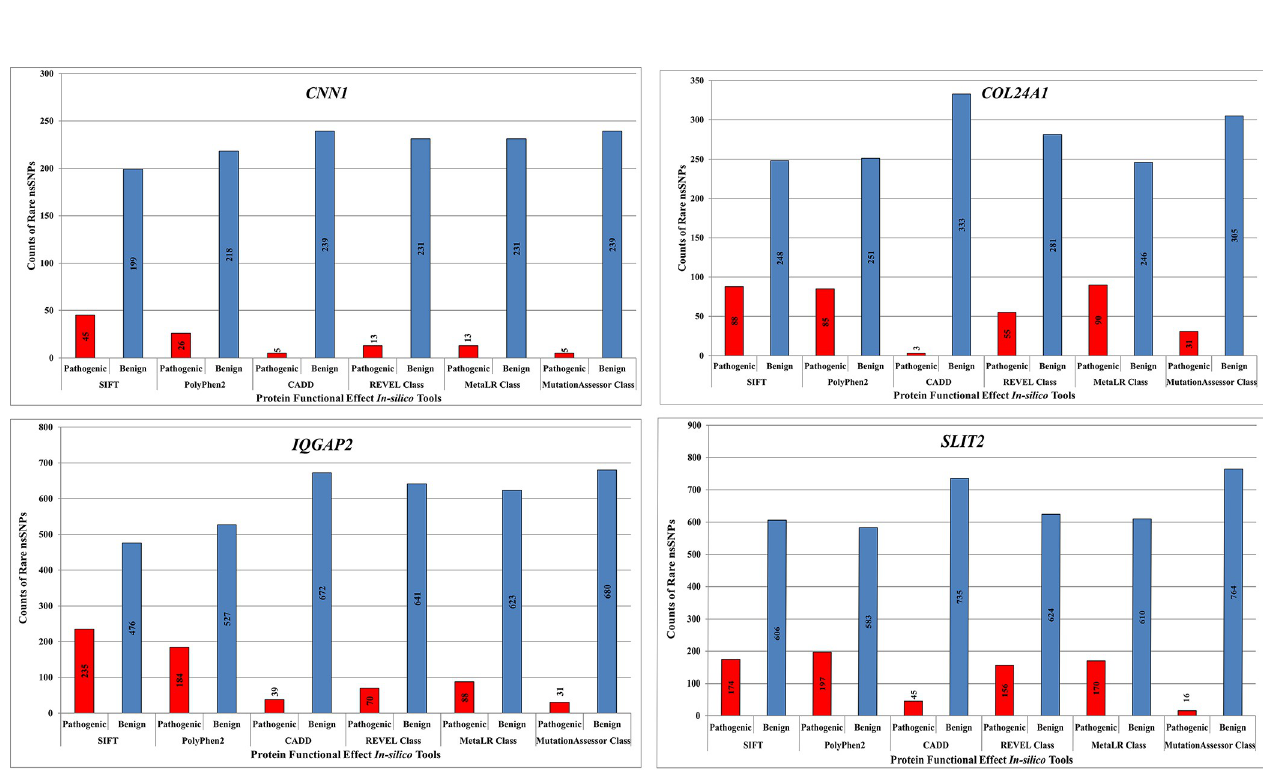
Fig 3. Downstream functional effect prediction of pathogenic SNPs based on various in-silico tools. A. CNN1 , B. COL24A1 , C. IQGAP2 , and D. SLIT2 .